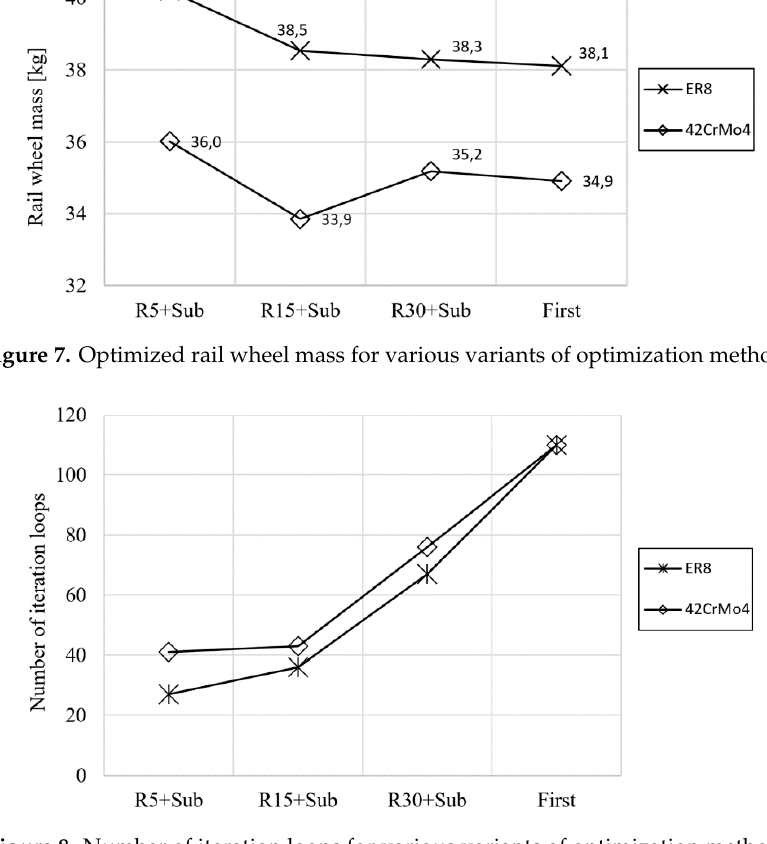
Figure 8. Number of iteration loops for various variants of optimization method.